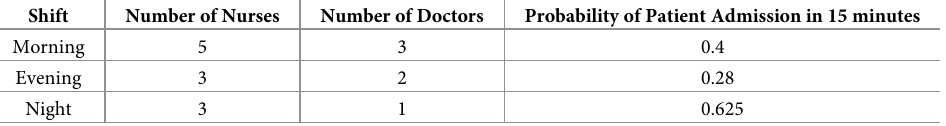
Table 2. Variations in staff capacity and probability of patient admission at Mnazi Mmoja Hospital’s maternity ward over a 24 hour period.